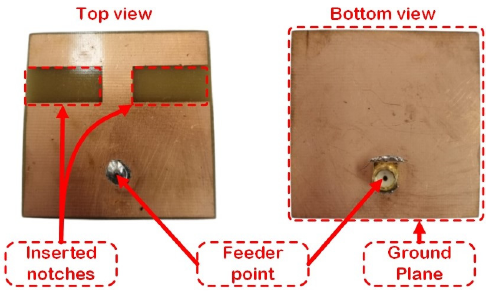
Figure 12. The developed IoT antenna.